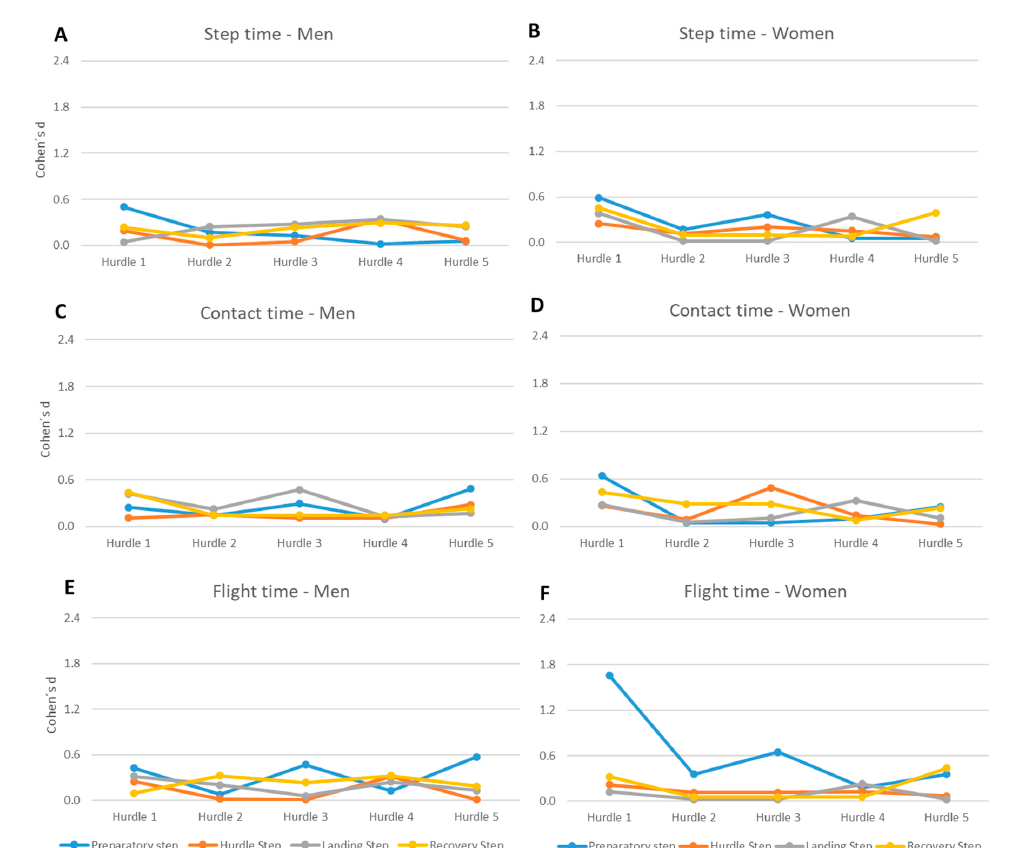
Figure 2. Magnitude of differences (Cohen’s d) for the temporal parameters (( A , B ) step time; ( C , D ) contact time; and ( E , F ) flight time) in relation to mean race values for men and women. An effect size greater than 0.6 or 1.2 was considered as moderate or large, respectively, by Hopkins et al. [25]. Step length also changed through the 60 m hurdle race in every step of the hurdle-unit phase, distance during the men’s race (F 3.82 = 27.91, p = 0.001, η p2 = 0.33) and in the take-off distance of the women’s race (F 3.74 = 62.29, p = 0.001, η p2 = 0.56). Step width also displayed meaningful differences